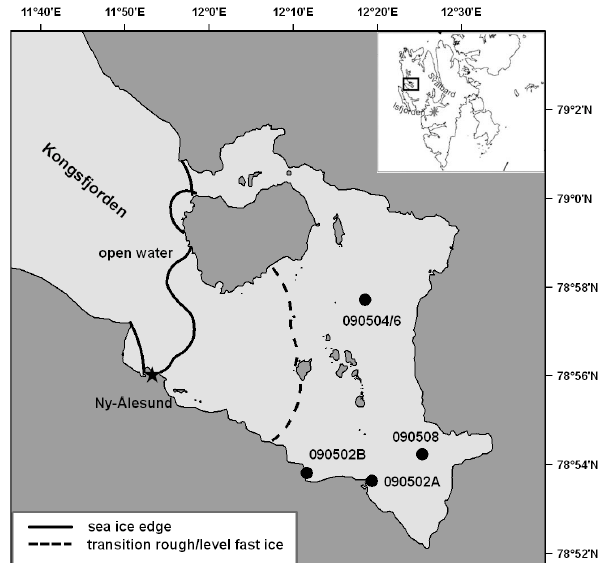
Fig. 1. Map showing sea ice stations in Kongsfjorden, Svalbard, in the vicinity of Ny- ˚Alesund. Solid line denotes the outer ice edge, and the dashed line indicates the outer edge of level first-year sea ice in the inner part of the fjord. Numbers denote day of sampling (yy/mm/dd).